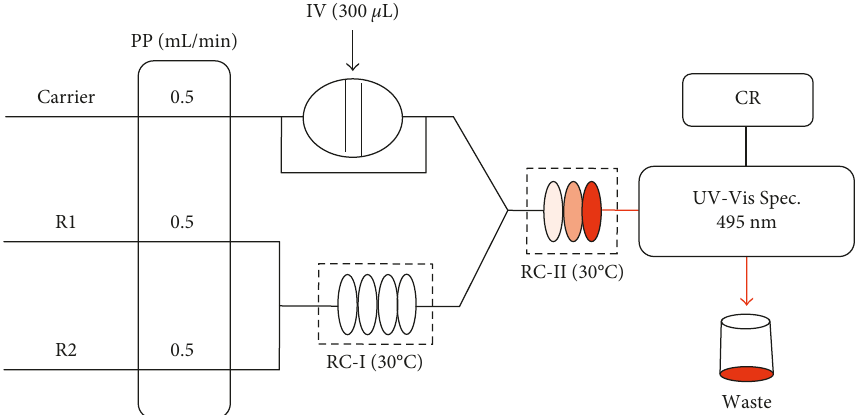
Figure 2: Optimised FI spectrophotometric manifold for the determination of ANTU. Carrier, 0.25% (v/v) ethanol solution containing 75mM sodium hydroxide; R1, 50mM sodium nitrite solution; R2, 100mM sulphanilic acid solution; PP, peristaltic pump; IV, injection valve; RC-I, reaction coil-I, 200cm; RC-II, reaction coil-II, 150cm; CR, chart recorder.